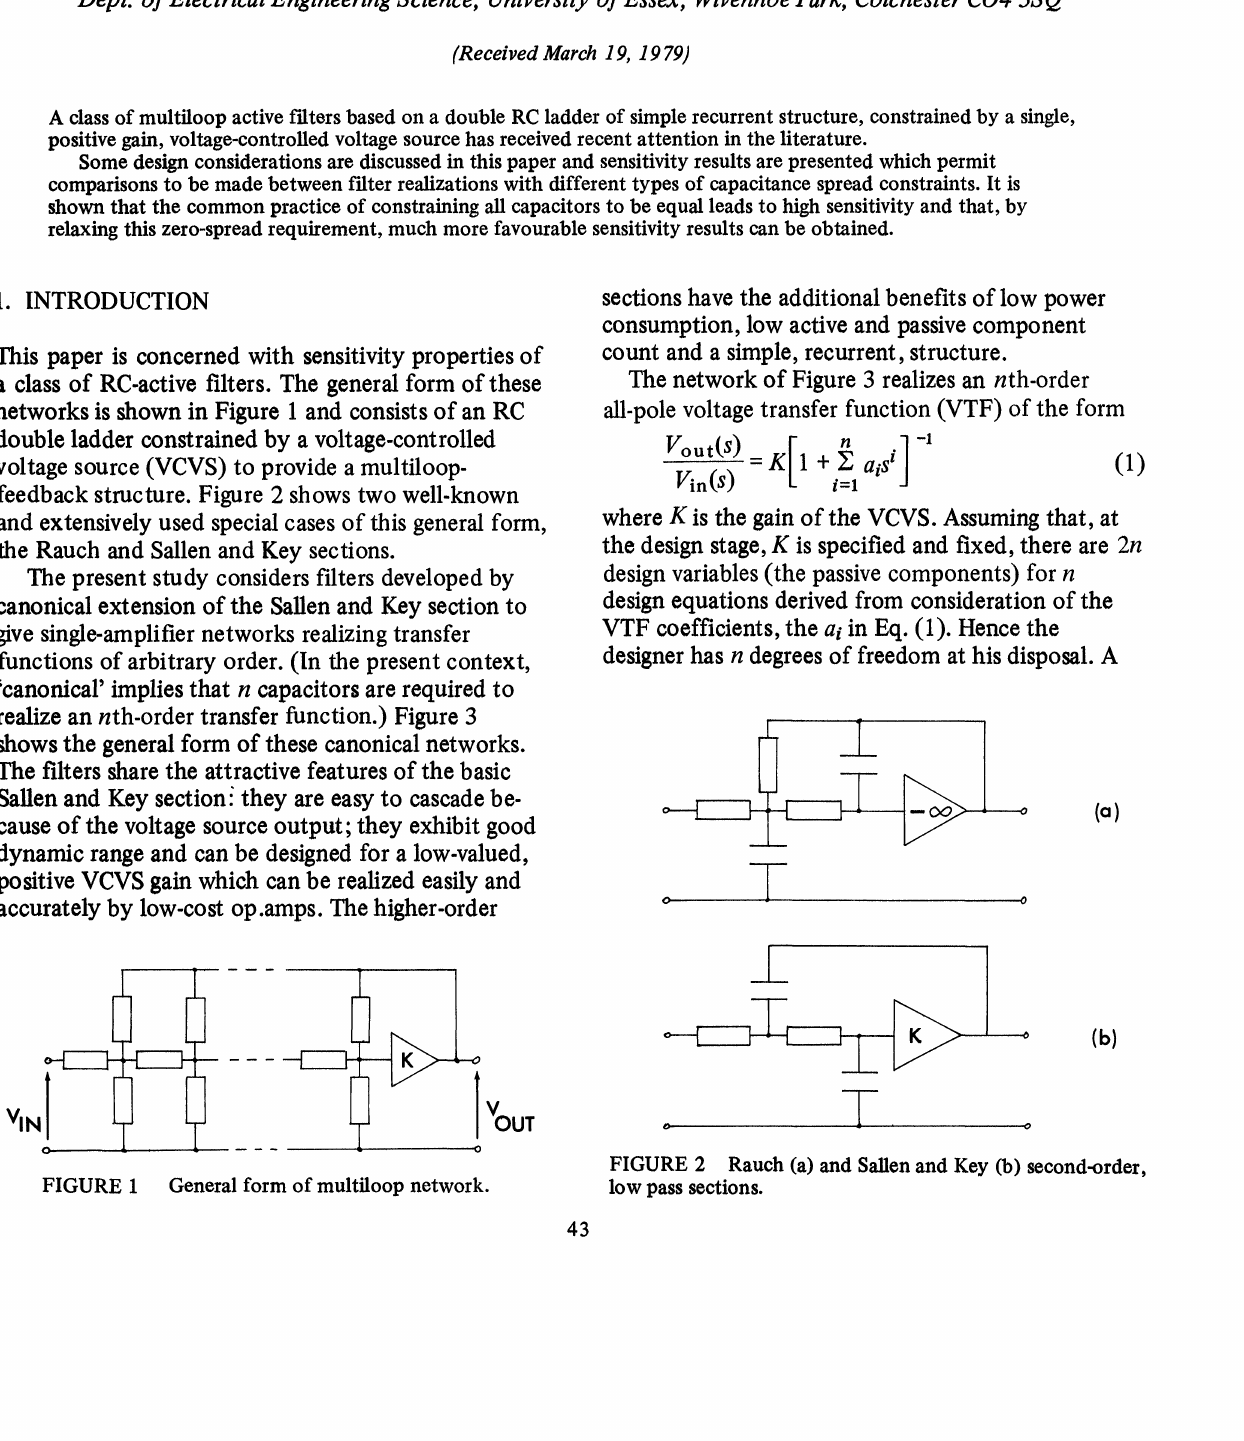
FIGURE 1 General form of multiloop network.